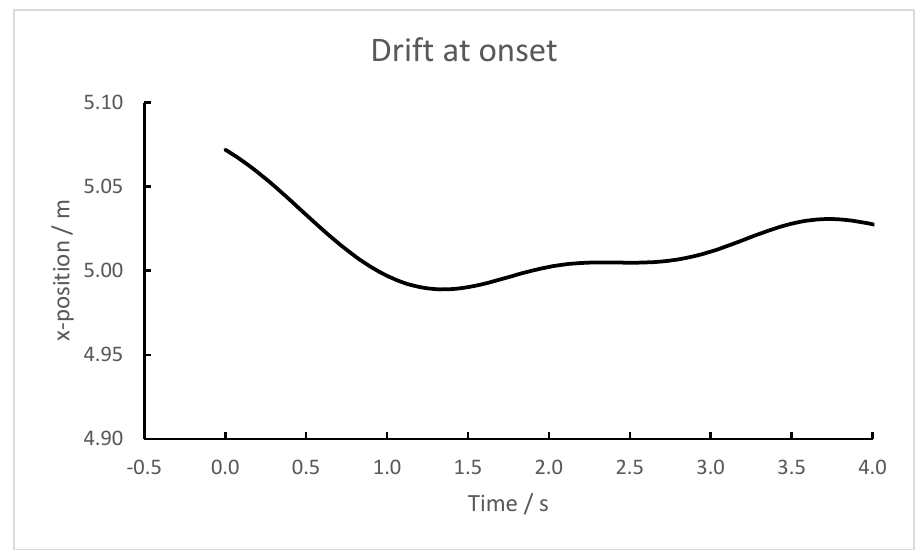
Figure 3. Recordings of the x ‐ coordinate of a transponder lying on the ground during the first 4 s of a recording. Note that the y ‐ axis does not start at zero.